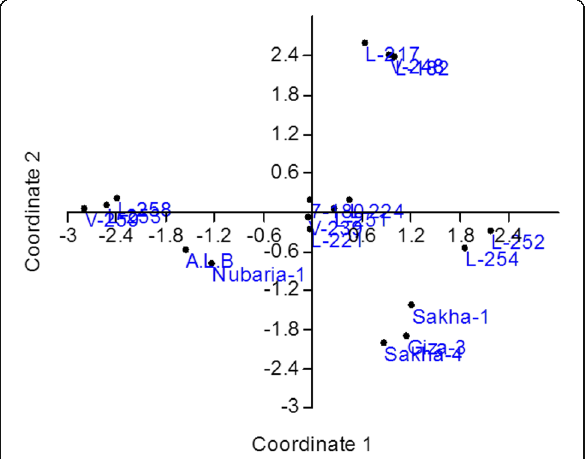
Fig. 2 Principal coordinate analysis (PCoA) of the 18 faba bean genotypes with SRAP marker data